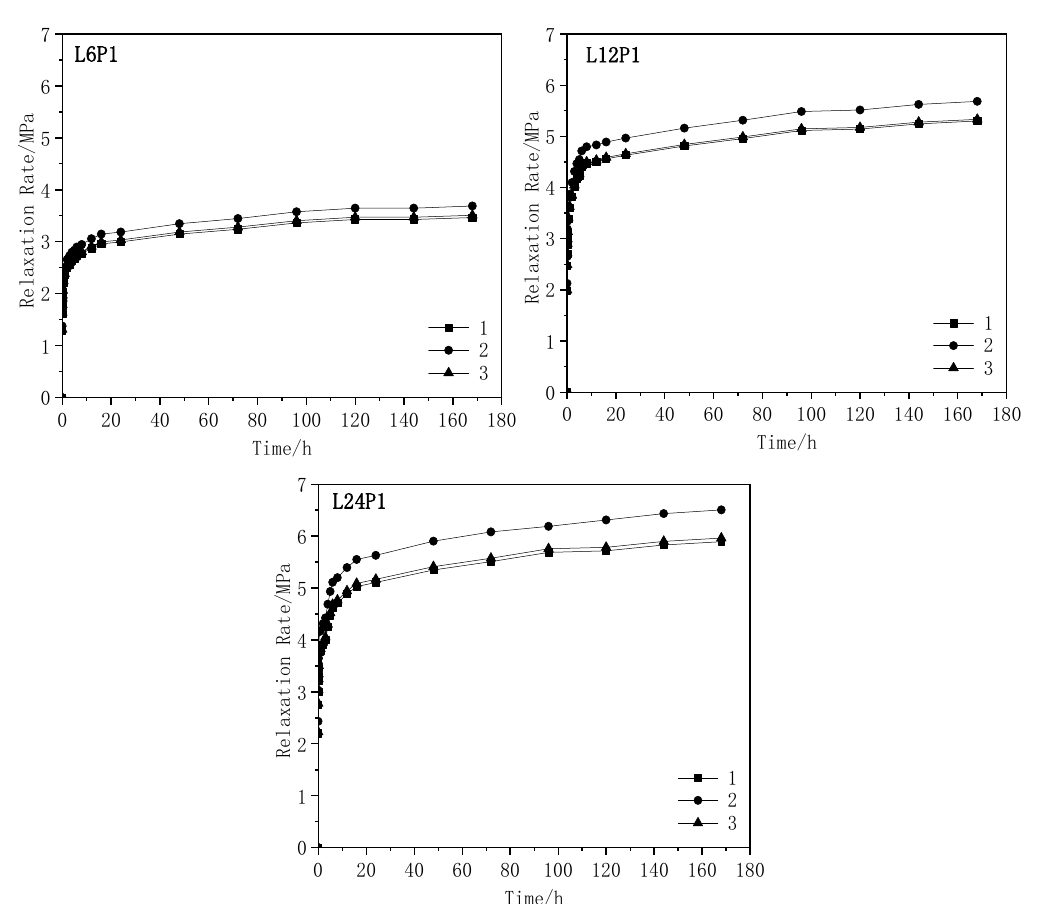
Figure 10. Time-dependent curves of relaxation rate at different locations of CFRP cloth. Table 6. Control tension stress at different positions of the specimen (unit: MPa). Strain Gauge No.